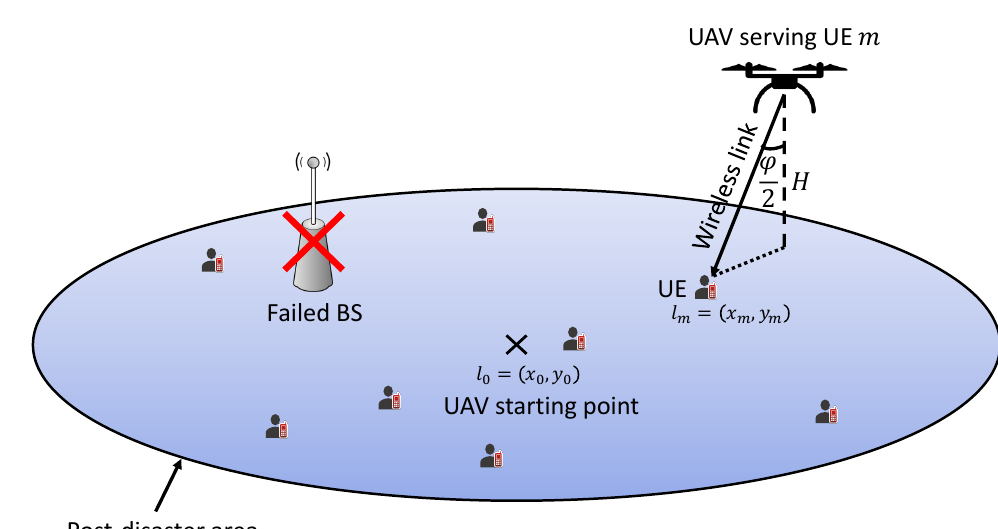
Figure 1. UAV emergency wireless communication